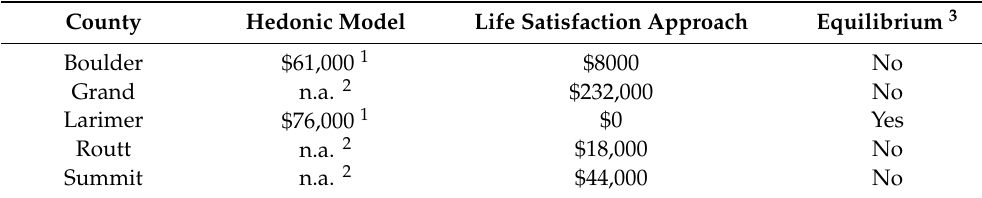
Table 4. Comparison of per household monetized economic losses from forest mortality using Hedonic Method (HM) and Life Satisfaction Approach (LSA)